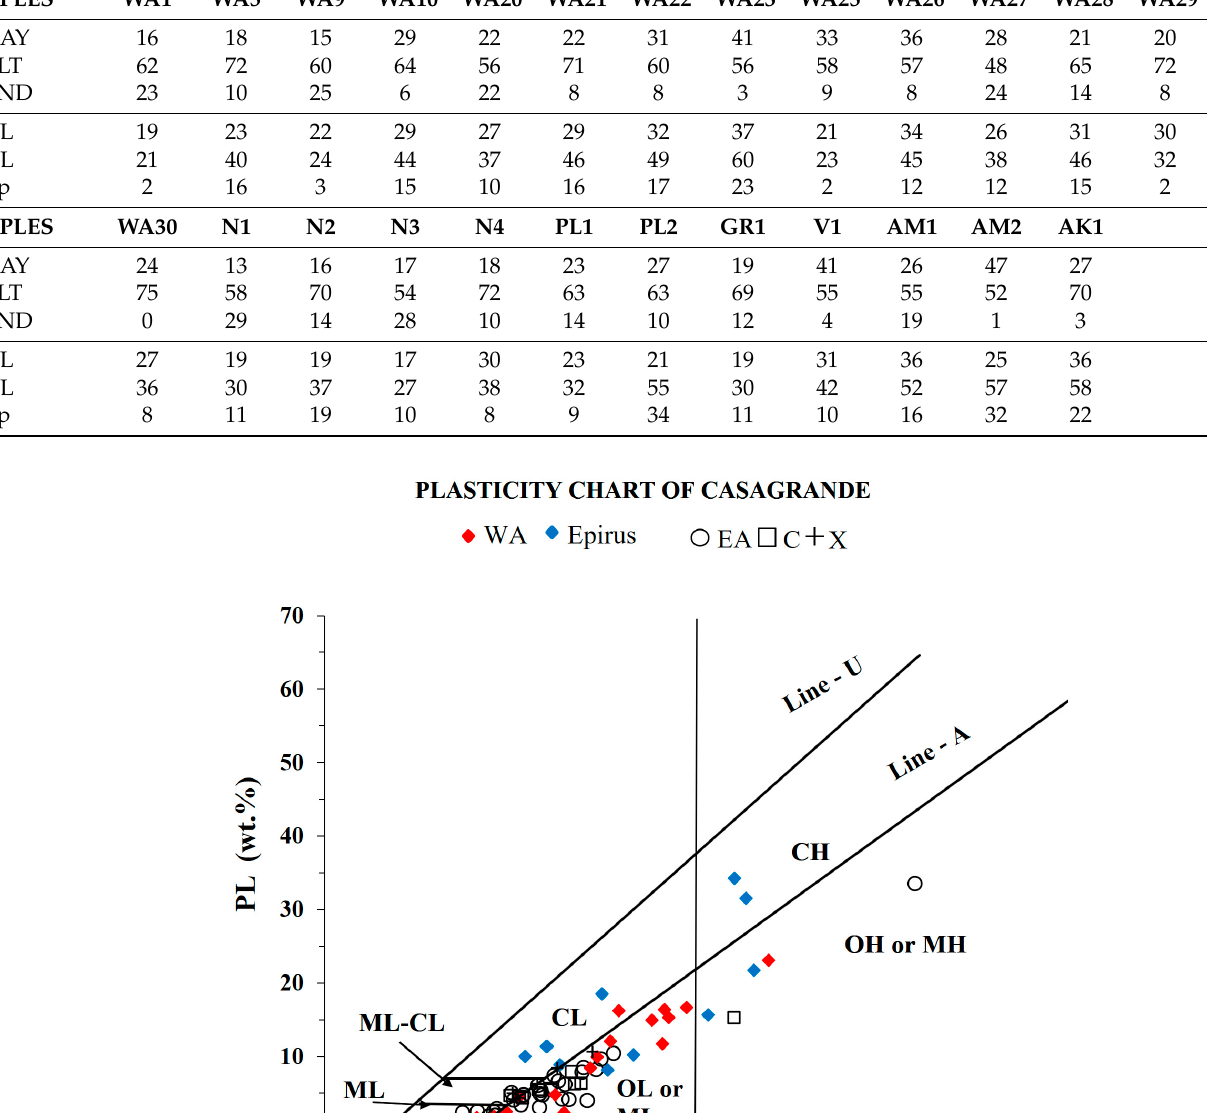
22 In terms of plasticity and particle size distribution of the studied samples, their plot in the plasticity chart proposed by Marsigli and Dondi [35] shows that samples from WA tend to be more plastic bodies than the rest of the eastern Peloponnese, whereas two